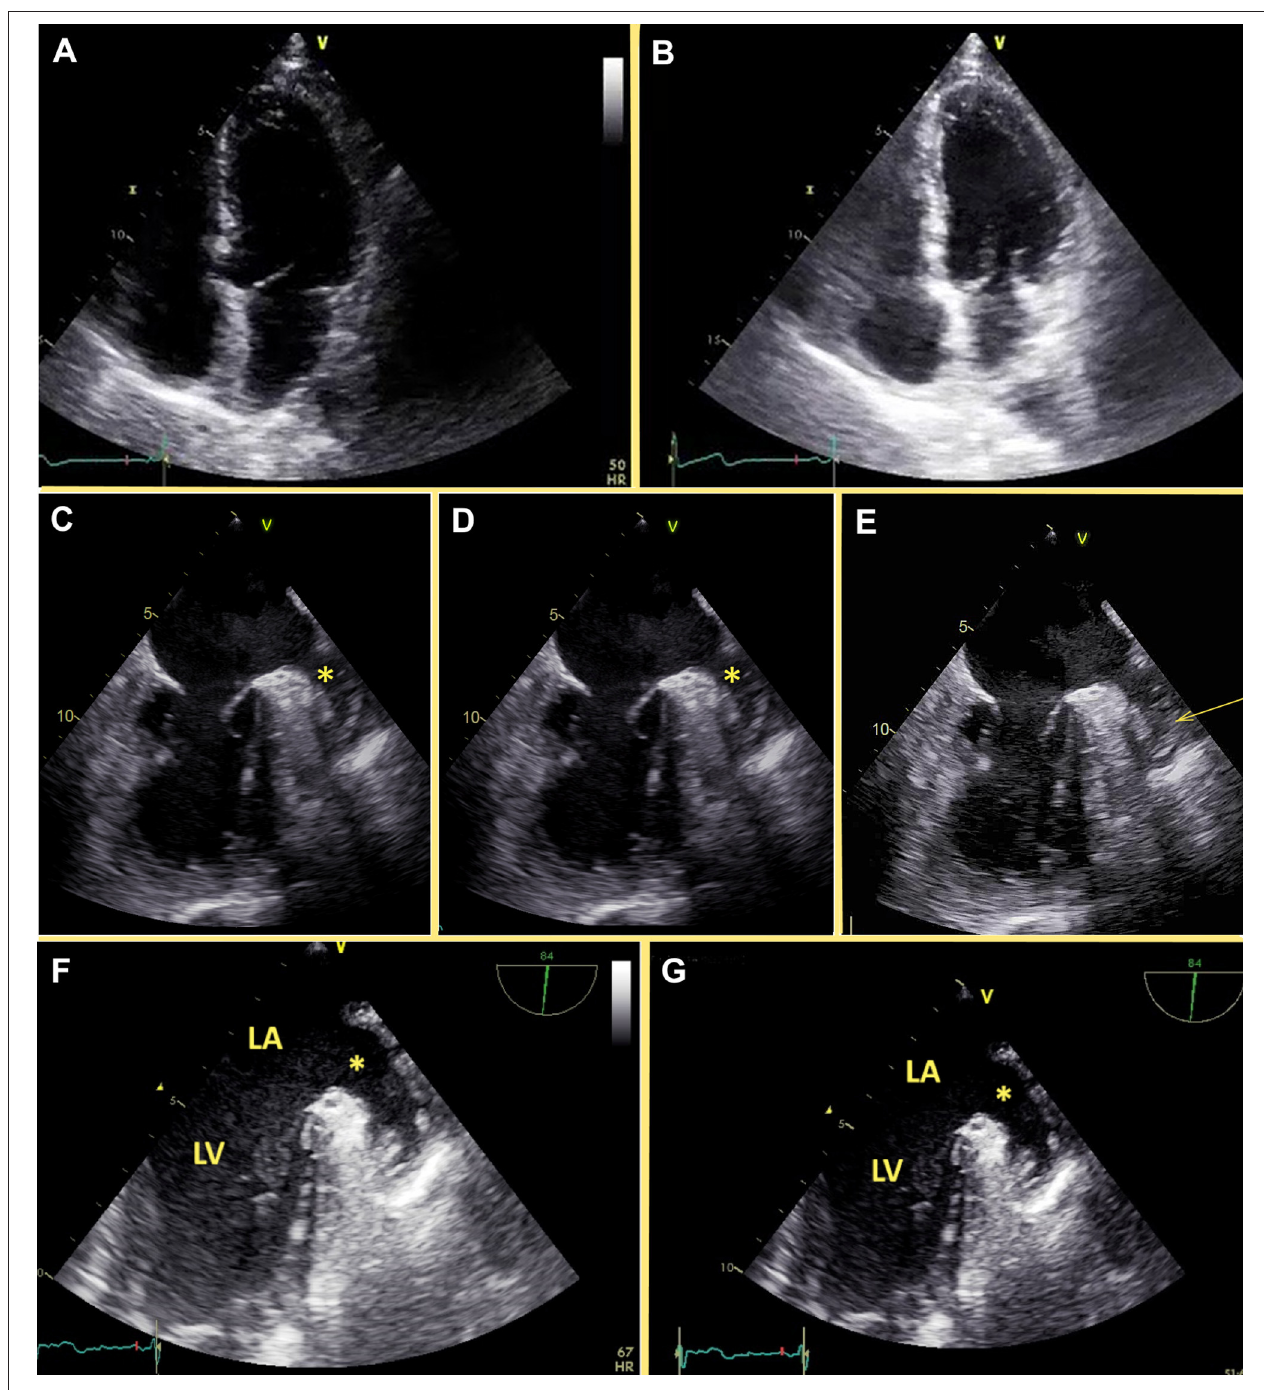
FIGURE 1 | Effect of different frame rates and compression on the echocardiography image quality. (A,B) Apical 4-chamber view of the same patients recorded at two different frame rates. (A) Left – at frame rate 44 fps, (B) Right – at frame rate 74 fps. Image with a higher frame (B) rate contains more echocardiography information than the image with a lower frame rate (A) . (C–E) TEE of the patient with atrial fibrillation before cardioversion. (C) Raw data. Swirling is present in the left atrium and the appendage (starr). (D) RLE lossless compression. Swirling is present in the left atrium and the appendage (starr). (E) Lossy compression. Significant swirling in the left atrium and is suspicious for thrombus in the left atrial appendage (arrow). (F,G) TEE of the patient with atrial fibrillation. (F) raw data, there is some swirling in the left atrium. (G) lossy compression, there is no swirling at all. LV, left ventricle; LA, left atrium.